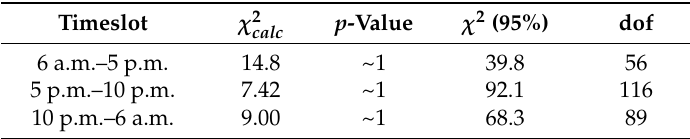
Table 2. Statistics on the testing